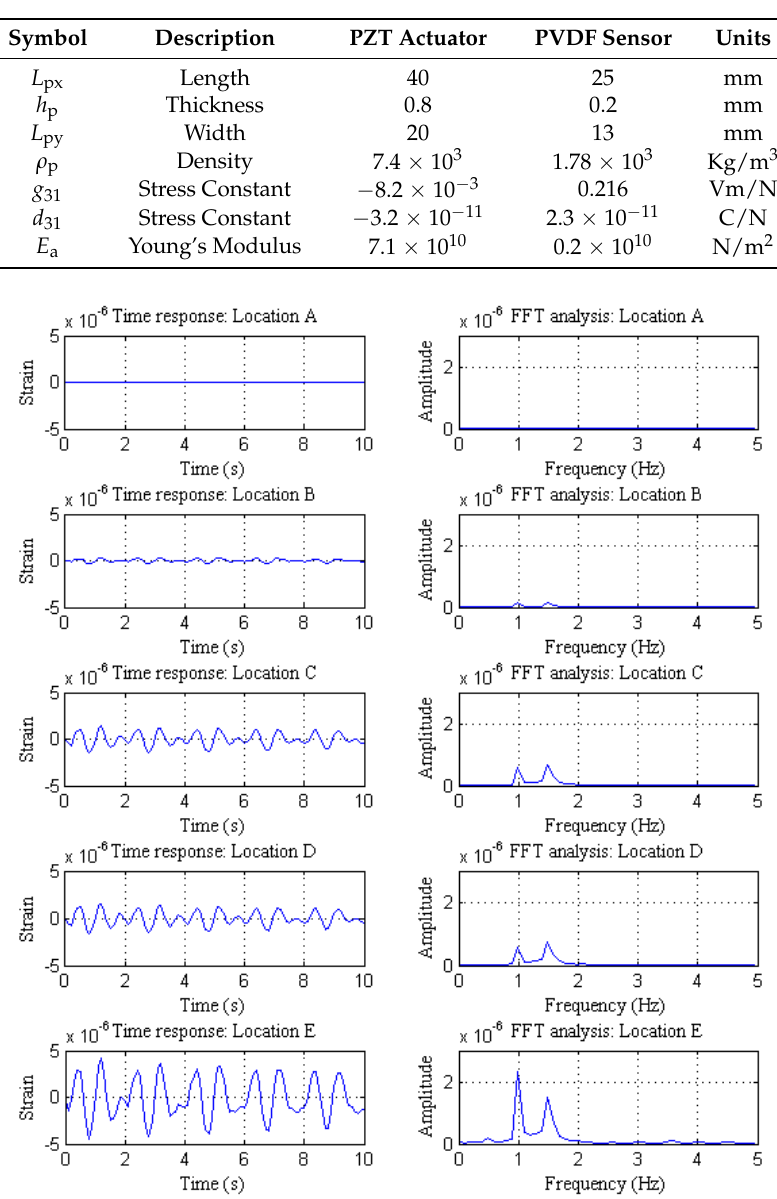
Table 2. Properties of the applied piezoelectric sensor and actuator.